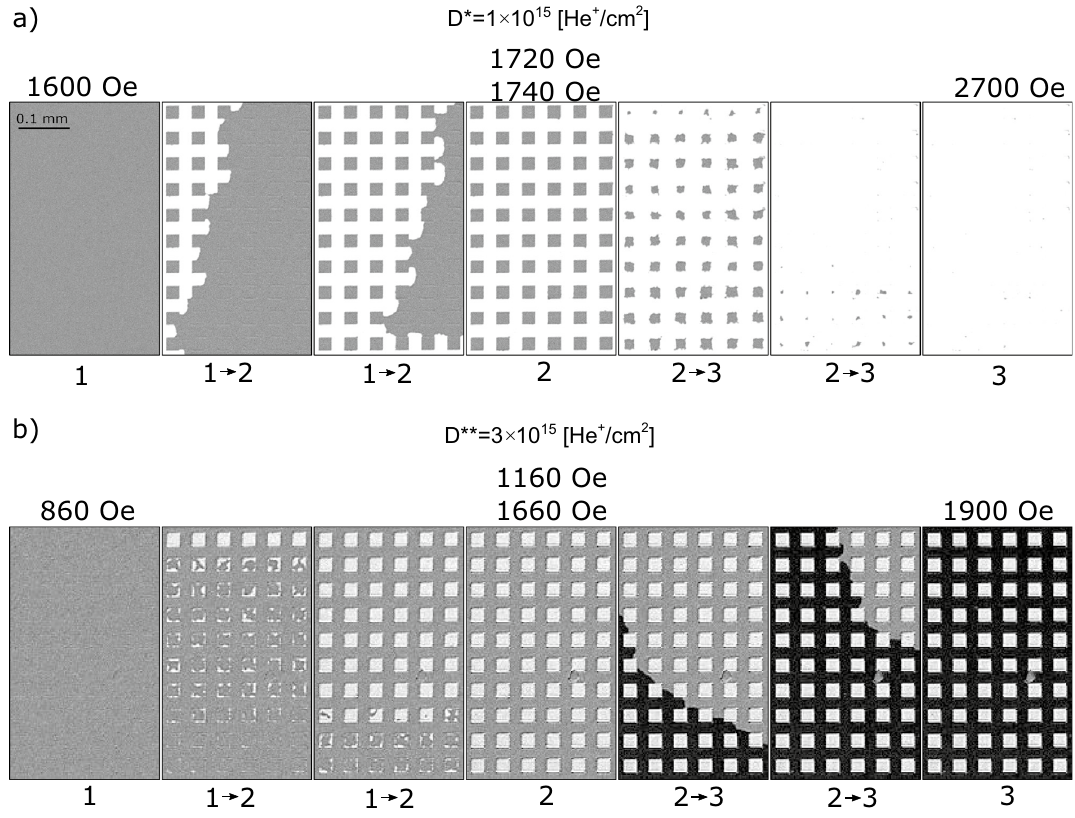
Figure 4. Representative P-MOKE microscopy differential images illustrating the magnetization evolution for the lattice of squares (sample B2, a = 25 μm) patterned with ion doses D * and D ** (panels ( a ) and ( b ), respectively) during reversal from saturation in negative magnetic field (state 1 in Fig. 3) to saturation in positive field (state 3 in Fig.